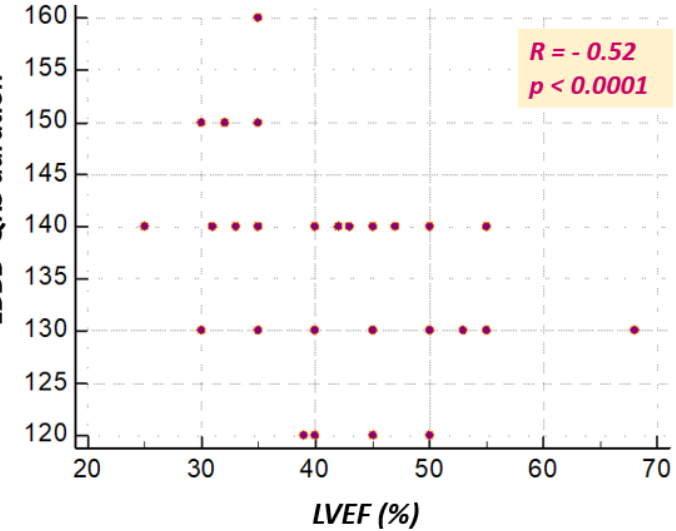
Figure 5. Correlation between LBBB-QRS complex duration and LVEF (%) in the general study population.